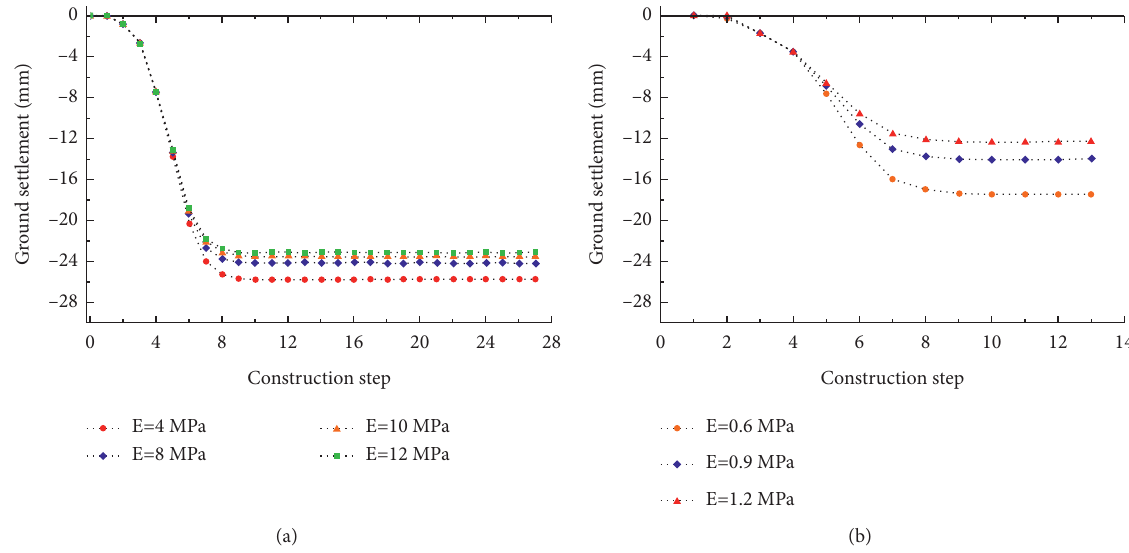
Figure 19: Longitudinal ground settlement of shield and pipe jacking under different elastic modulus: (a) Longitudinal settlement of shield. (b) Longitudinal settlement of pipe jacking.